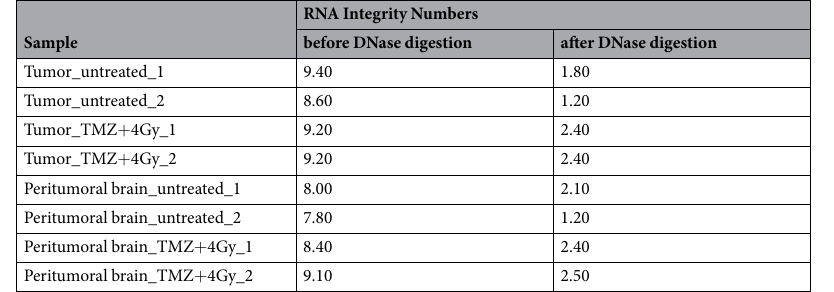
Table 1. RNA integrity number before (left) and after (right) DNase digestion.